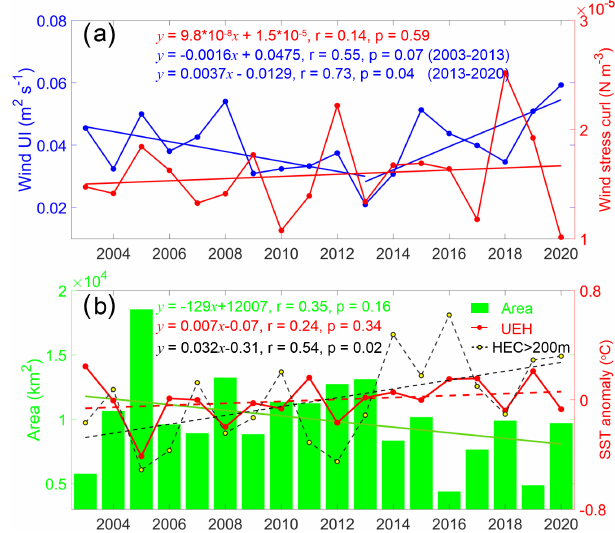
Figure 4. Time series of upwelling index (UI) and upwelling char- acteristics. (a) Time series of mean sea surface wind UI and wind stress curl in HEC region. The dotted blue curve denotes the mean UI during June–August; the dotted red curve is mean wind stress curl during June–August; and the blue and red curves are the trends of the UI and wind stress curl, respectively. (b) Time series of up- welling area and SST. The green bar denotes the area of UEH re- gion. The dotted red and black curves denote mean SST of the UEH region and the slope region (depth > 200m) in HEC, respectively. The green, red, and black lines are the trends of the upwelling area and the mean SST in UEH and slope area,